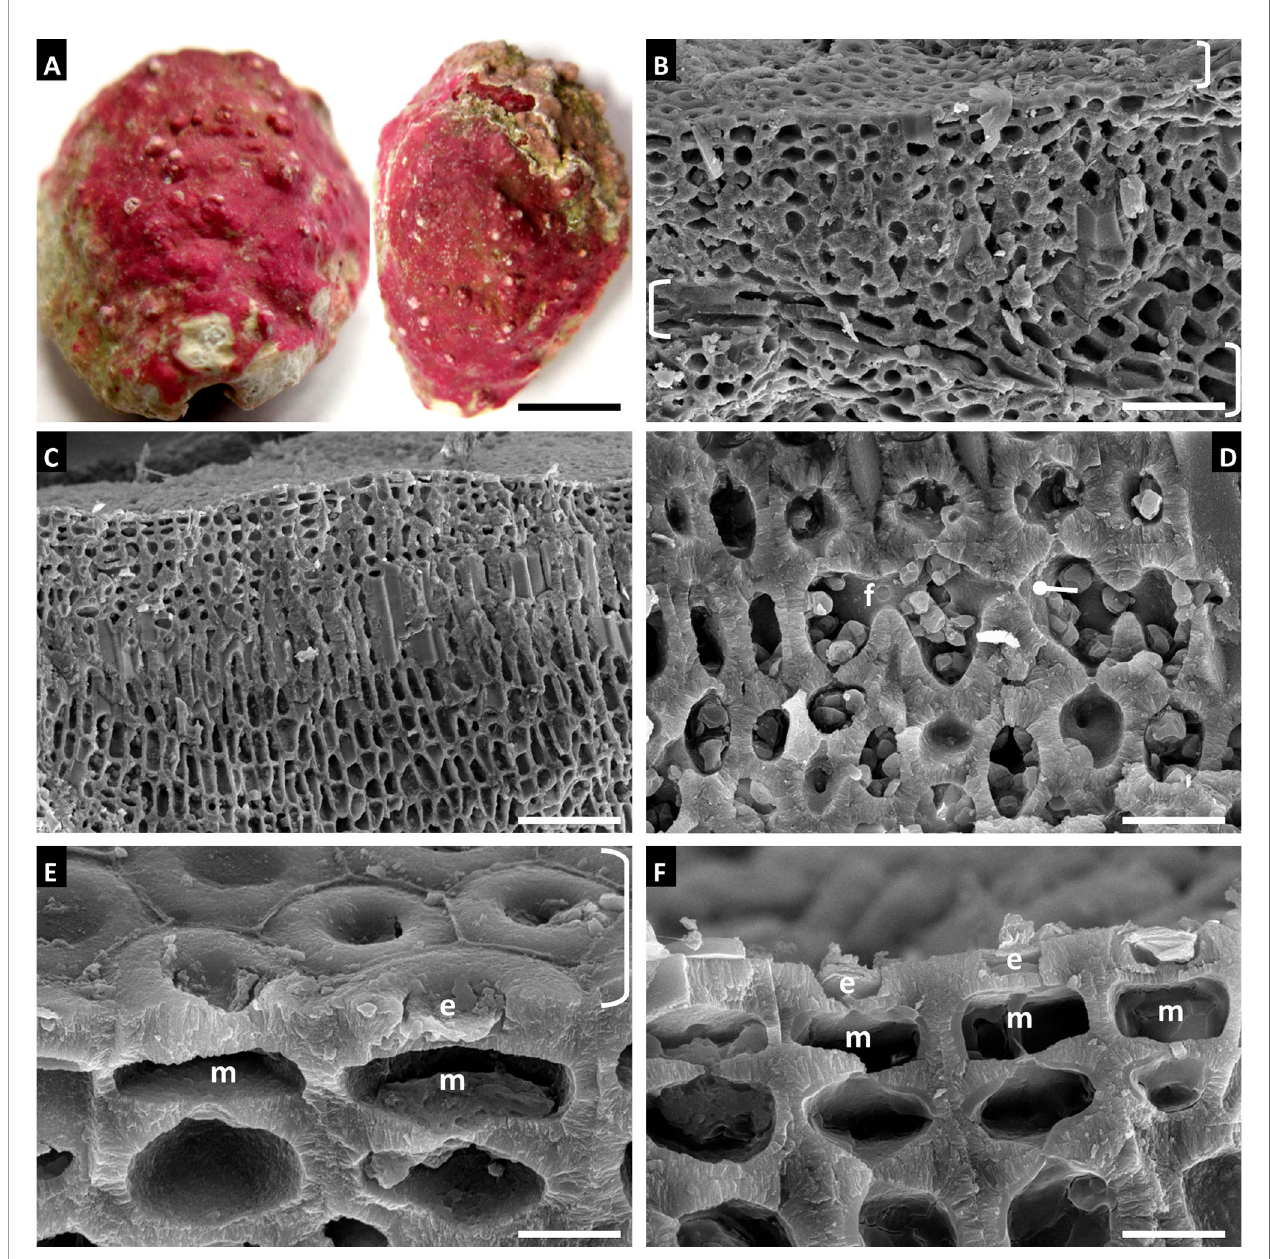
FIGURE 7 | Sporolithon sp., voucher no. LAF 6726. (A) Thallus habit epizoic upon Naria acicularis shell. Scale bar = 0.4 cm. (B) Vertical fracture showing incomplete view of hypothallus (lower brackets), perithallus, and partial surface view of epithallus (upper bracket). Scale bar = 30 µm. (C) Vertical fracture of thallus showing perithallus. Scale bar = 55 µm. (D) Magni fi ed view of perithallus showing cell fusion (f) and secondary pit connection (circle pointer). Scale bar = 11 µm. (E) Surface view of epithallus (bracket) and partial section view showing epithallial cells (e) and intercalary meristematic cells (m). Scale bar = 5 µm. (F) Vertical fracture showing epithallial cells (e) and intercalary meristematic cells (m). Scale bar = 6